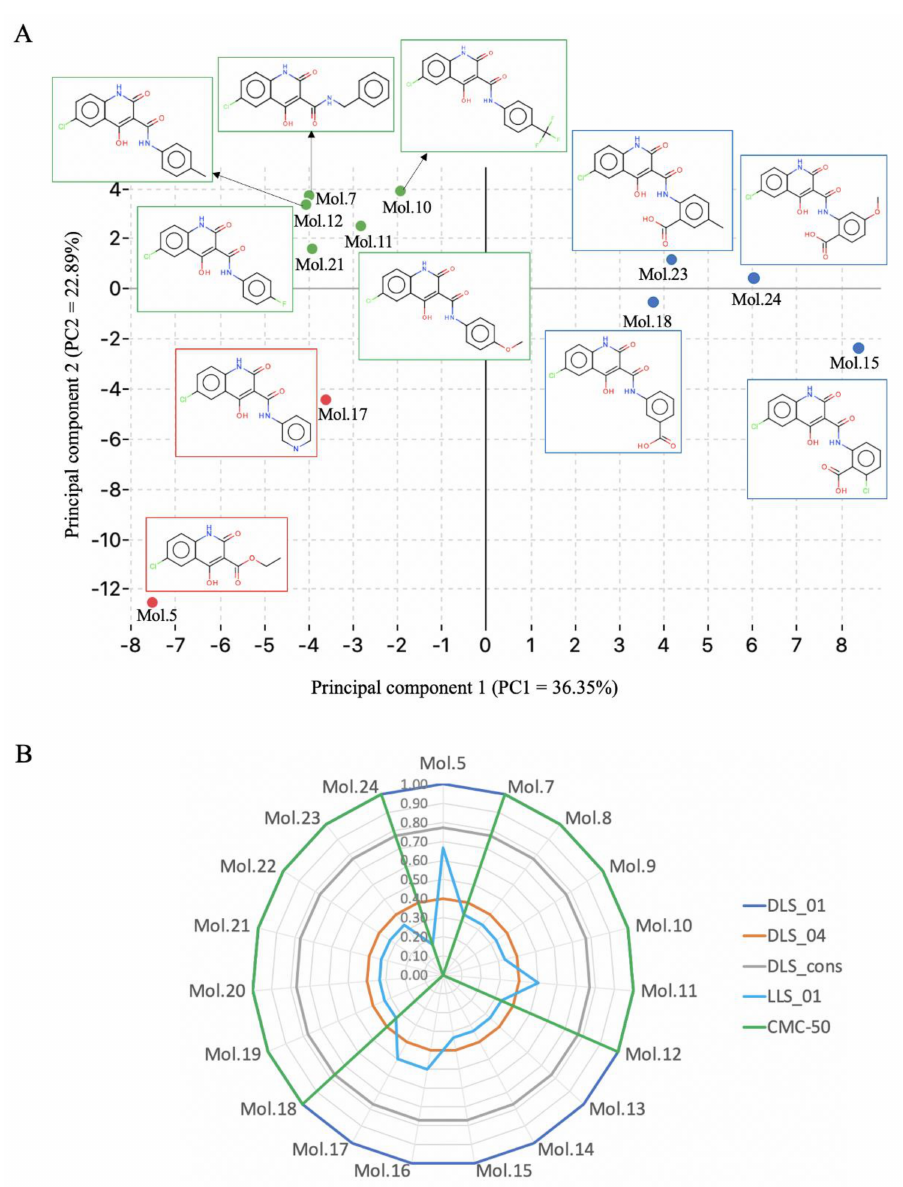
Figure 8. Molecular descriptor analysis. ( A ) A graphical 2D representation of the principal component analysis of molecular descriptors. PC1 explaining 36.35% of the variation in descriptor values is on the x-axis, and PC2 explaining 22.89% of the variation in descriptor values is on the y-axis. Descriptor used for the analysis belong two major categories of molecular descriptors: (1) drug-like indices; (2) molecular properties and P_VSA-like descriptors. ( B ) Radar plot of a representative set of 5 molecular drug-like and lead-like molecular descriptors that showed variability for the same